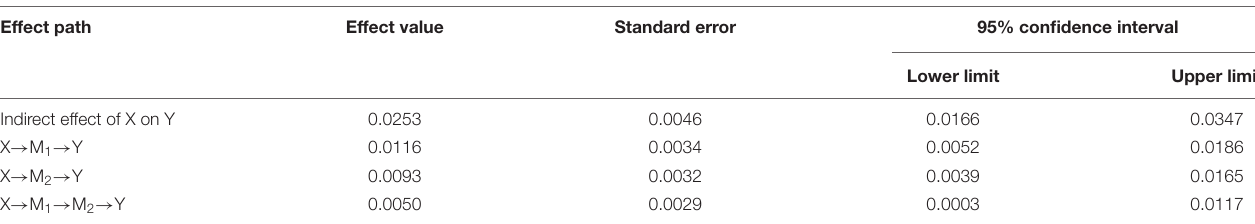
TABLE 6 | Chain intermediary